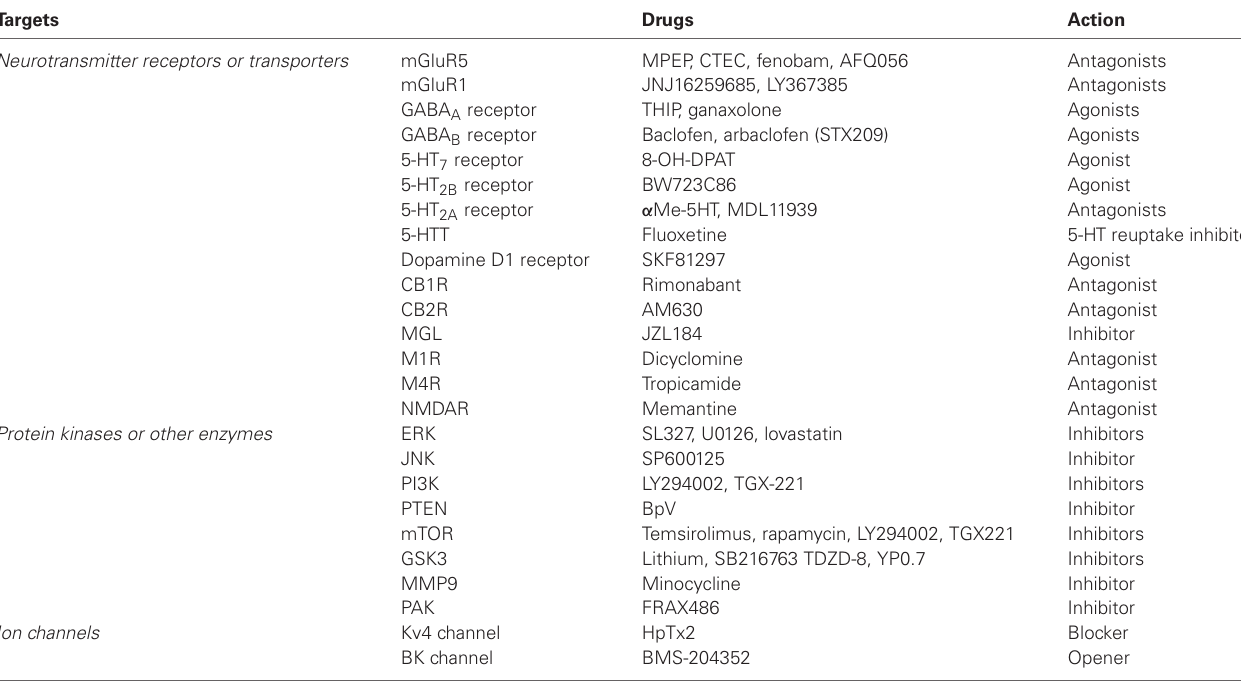
Table 1 | Therapeutic targets and relative drugs in preclinical studies of fragile X syndrome .